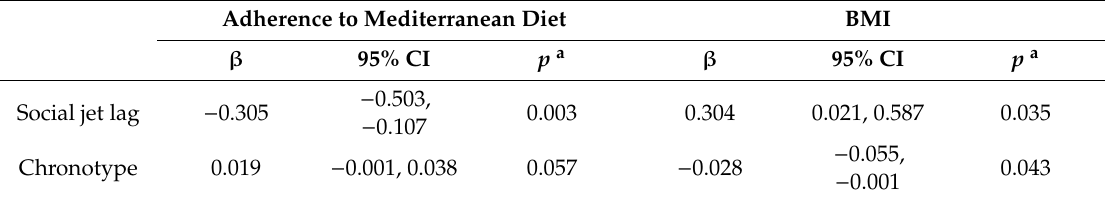
Table 3. Associations between adherence to Mediterranean diet, BMI and circadian related